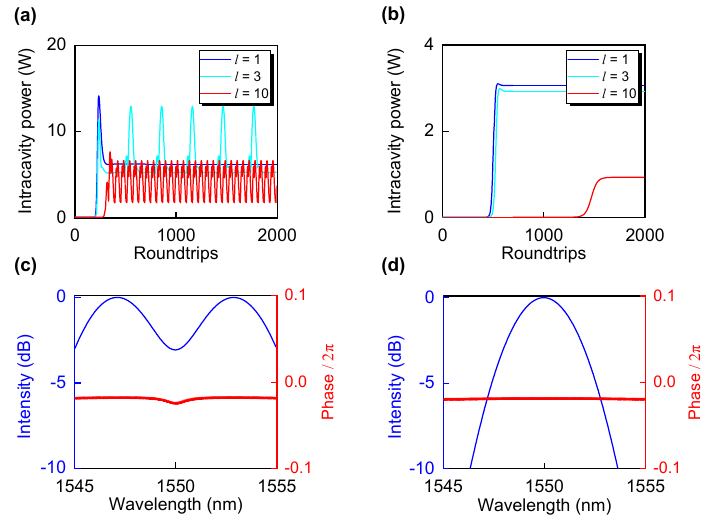
Figure 3. The evolution of the intracavity power of the signal field A ( a ) without ( γ 1 = γ 2 = γ 12 = γ 21 = 0) and ( b ) with ( γ 1 = γ 12 = 0.66 W − 1 m − 1 , γ 2 = γ 21 = 1.32 W − 1 m − 1 ) third-order nonlinearity for the detuning l = 1,3,10 .The spectrum profile and relative phases between comb lines ( c ) without and ( d ) with third-order nonlinearity for l = 10.